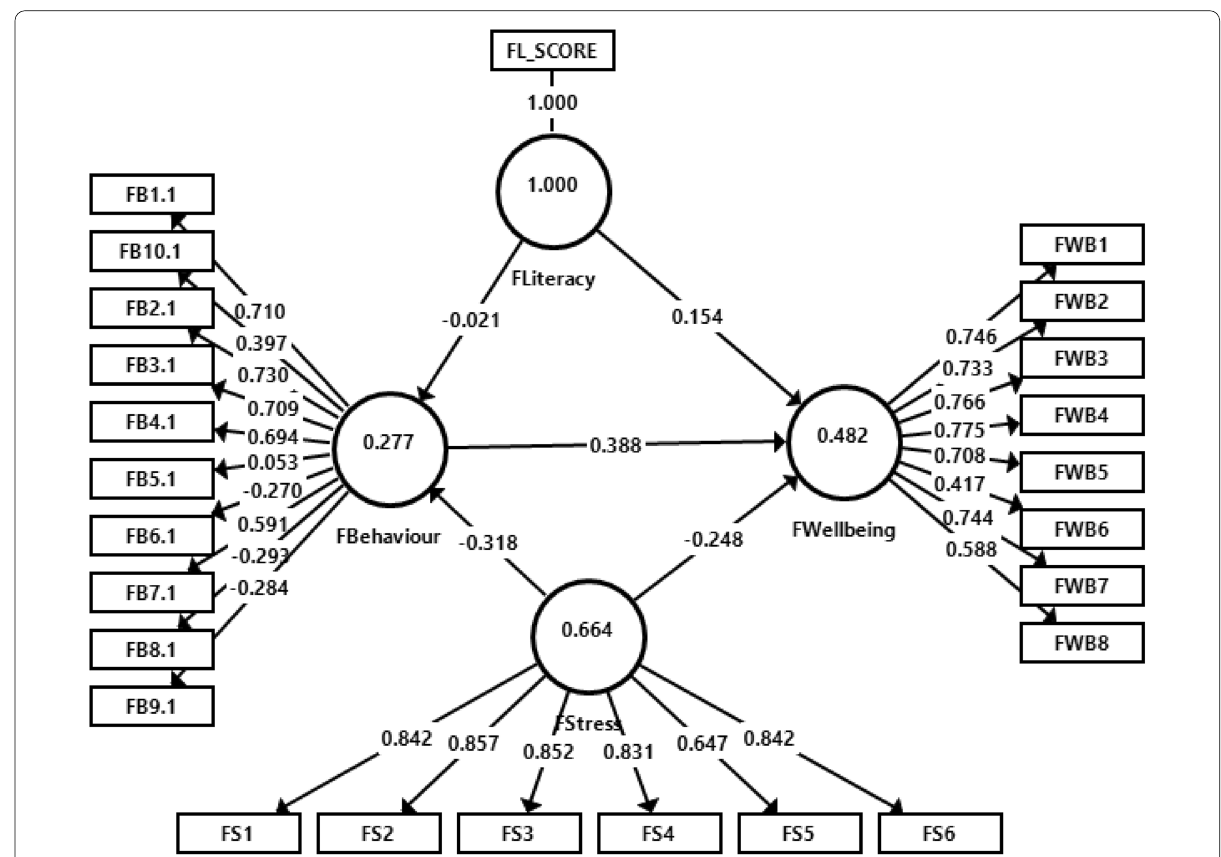
Fig. 2 Initial results of measurement model analysis (Loadings and